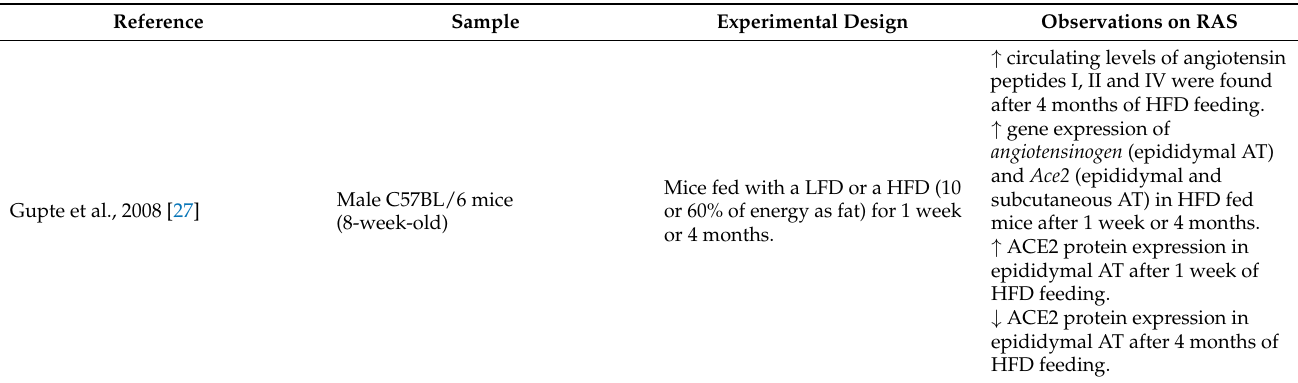
Table 1. Selected preclinical studies addressing the influence of different dietary patterns and weight-loss strategies on adipose tissue renin–angiotensin system